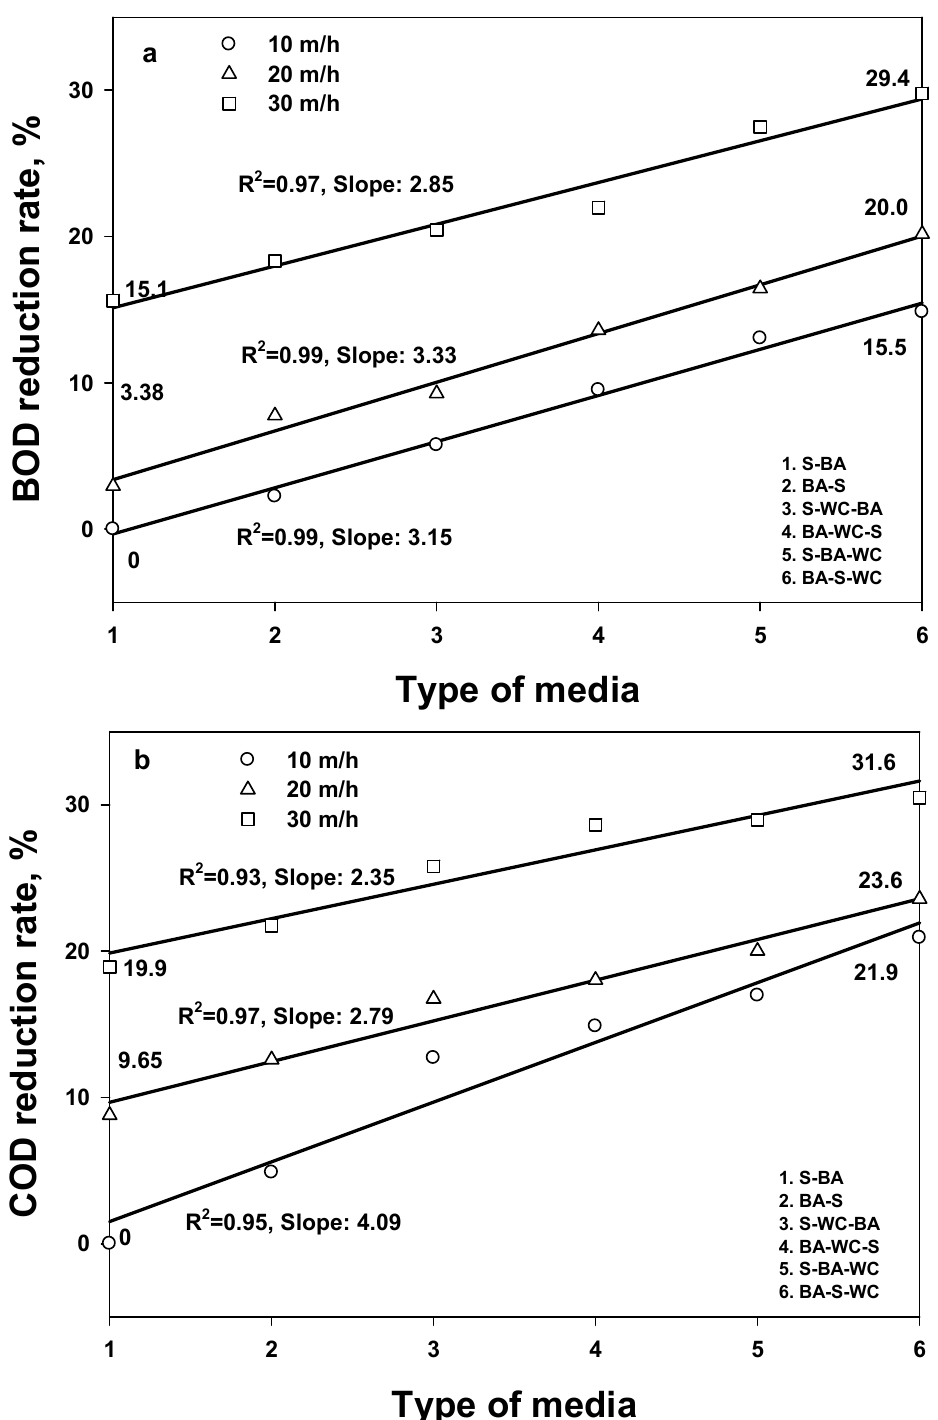
Figure 3. Reduction rates (%) of removal efficiency for BOD ( a ) and COD ( b ) for six media types and three different HCs (10, 20, and 30 m/h).